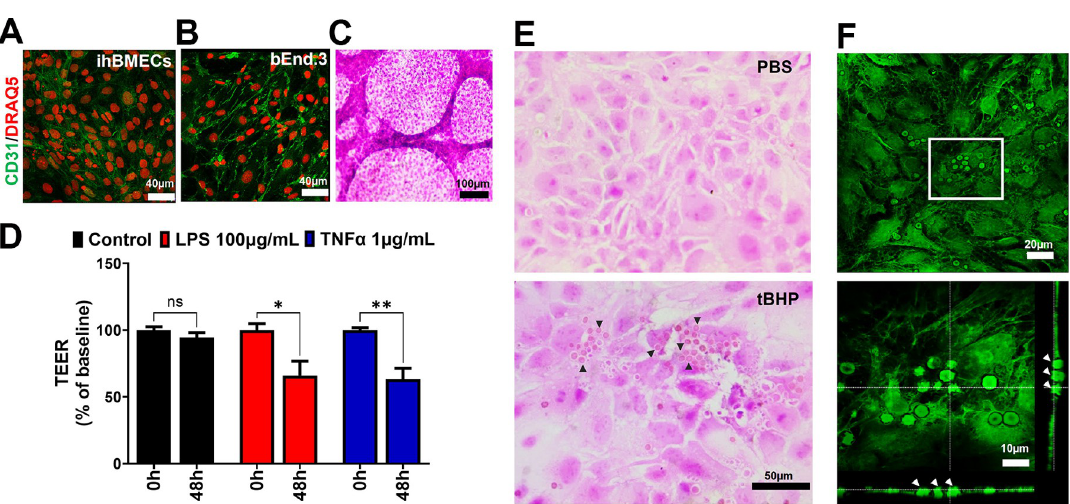
Fig 4. Vascular phenotype, response to inflammatory stimuli, and erythrophagocytic phenotype of ihBMECs. CD31 immunostaining in the ihBMECs ( A ) and the bEnd.3 cells ( B ). Tube-like formation by the ihBMECs grown on collagen and fibronectin coated Transwell inserts ( C ). ihBMECs respond to two inflammatory stimuli, LPS and TNF α , and show a significant reduction in TEER measurements ( D ). H&E-stained images show robust attachment and engulfment of tBHP-treated red blood cells with ihBMECs ( E ). Aged red blood cell internalization was further confirmed by maximum projection and orthogonal confocal microscopy images of H&E-stained cells showing the ihBMECs and tBHP red blood cells in autofluorescent green signal ( F ). Arrowheads show aged red blood cells internalized by the ihBMECs in E and F. Scale bar = 40 μ m in A-B, 100 μ m in C, 50 μ m in E, and 20 μ m or 10 μ m in F. Data are presented as mean ± SEM of n = 3 independent repeats, and � p < 0.05, �� p < 0.01 by two-way ANOVA and Holm-Sidak post hoc test in